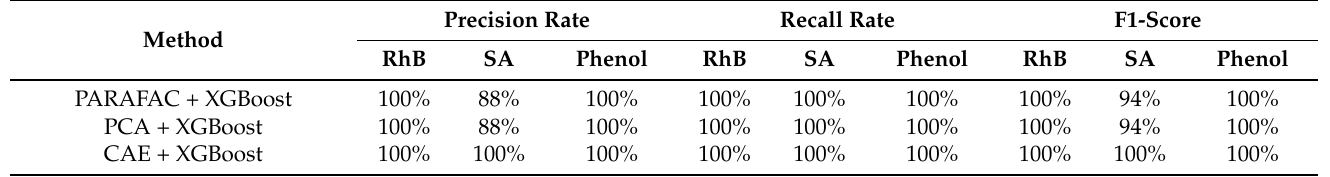
Table 1. Comparison of detection results of high concentration organic pollutants a . Precision Rate Recall Rate Method